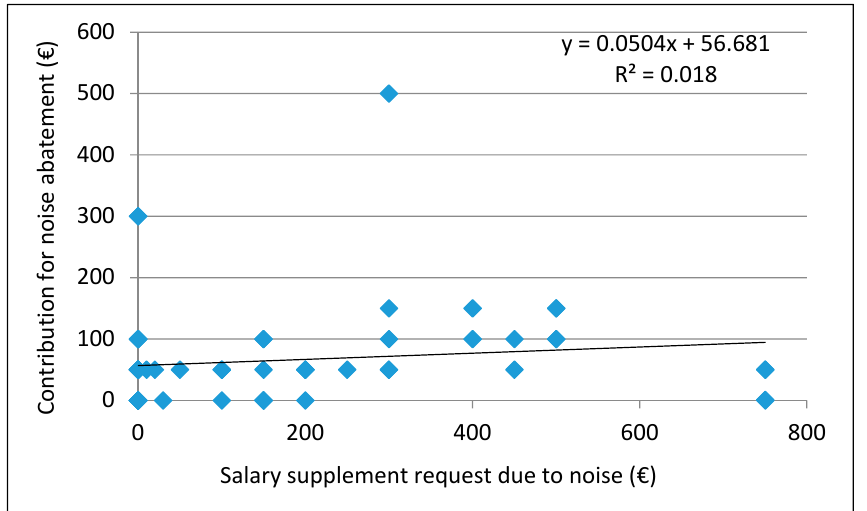
Figure 4. Dependence of annual contribution amount for noise abatement on requests for salary supplement due to noise.